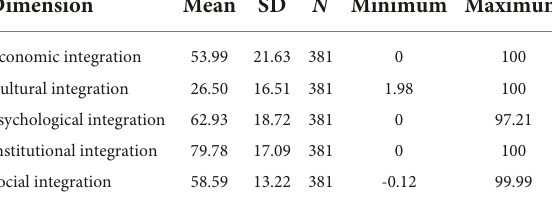
TABLE 2 Social integration and scores of each